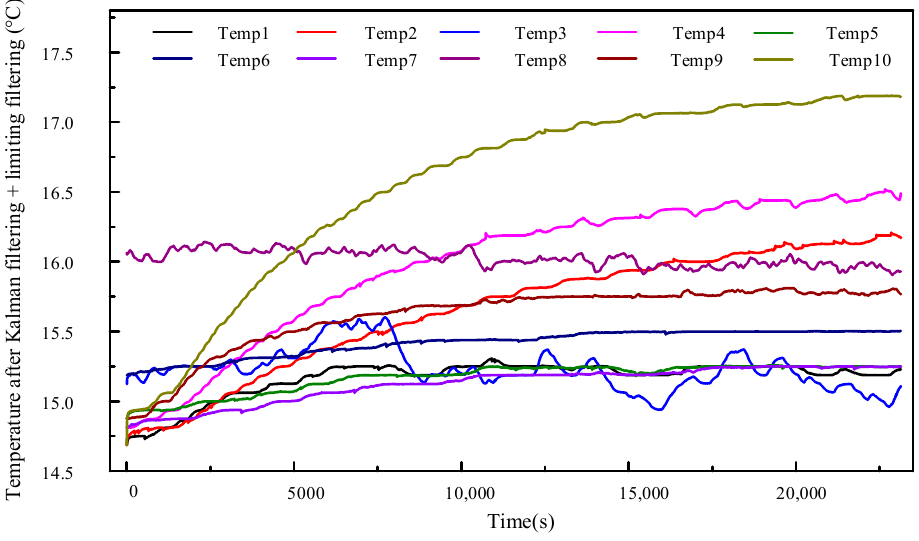
Figure 8. Limit filtering and Kalman filtering of raw data.